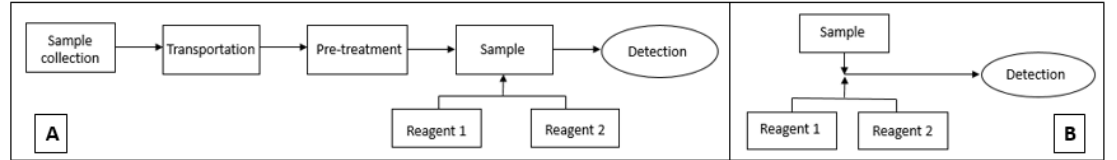
Figure 1. ( A ) Conventional method analysis incorporating multiple steps for Cr VI analysis, ( B ) microfluidic detection-based analysis using modified 1,5-diphenylcarbazide method for Cr VI detection.